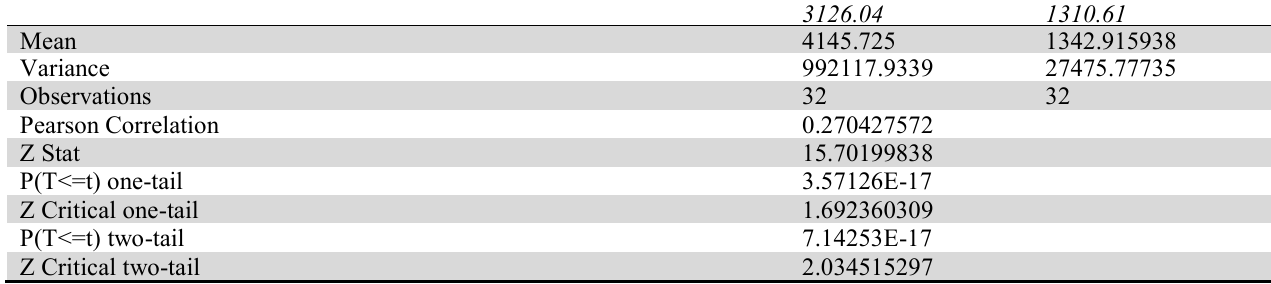
Post Crisis Influence of Standard and Poor’s on NSE 20 Share